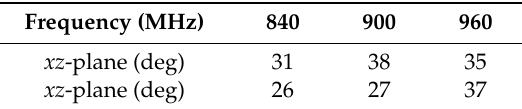
Figure 9. Simulated (dashed), measured (continuous), and theoretical (dashed-dotted) radiation patterns: ( a ) 870 MHz, on the xz -plane; ( b ) 870 MHz, on the yz -plane; ( c ) 930 MHz, on the xz -plane; ( d ) 930 MHz, on the yz -plane. Table 1. Antenna array AR ≤ 3 dB